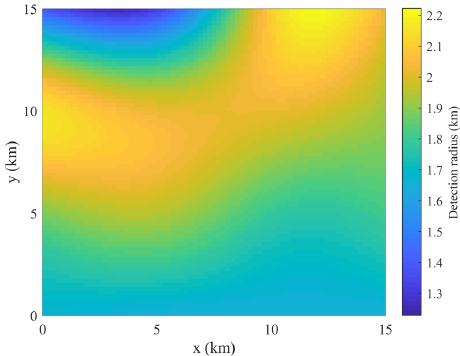
Figure 4. Detection radius map.